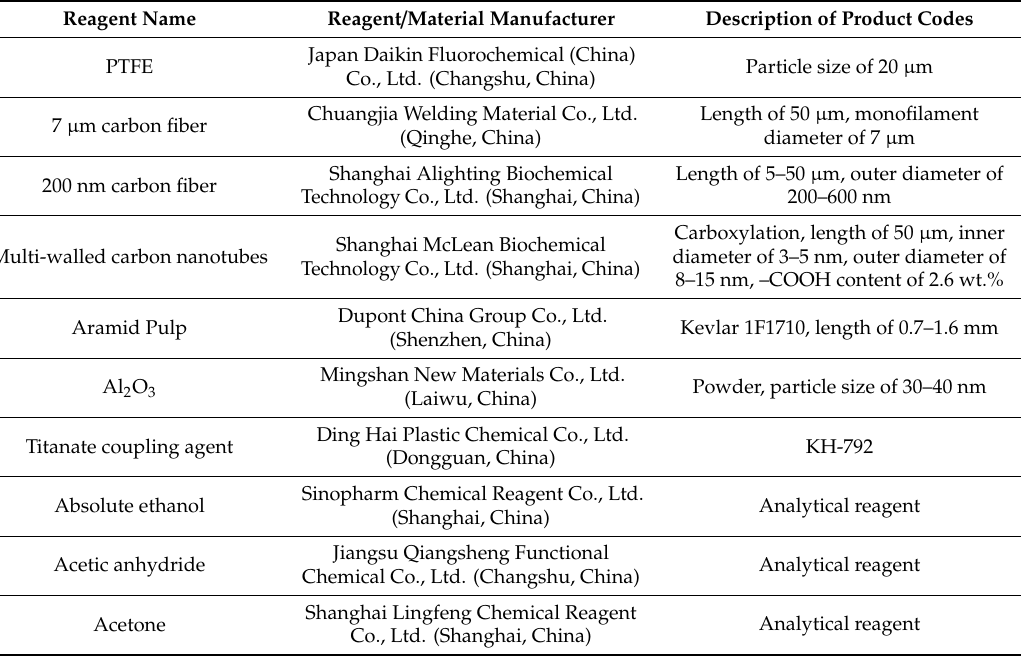
Table 1. Main reagents and materials used in the test.